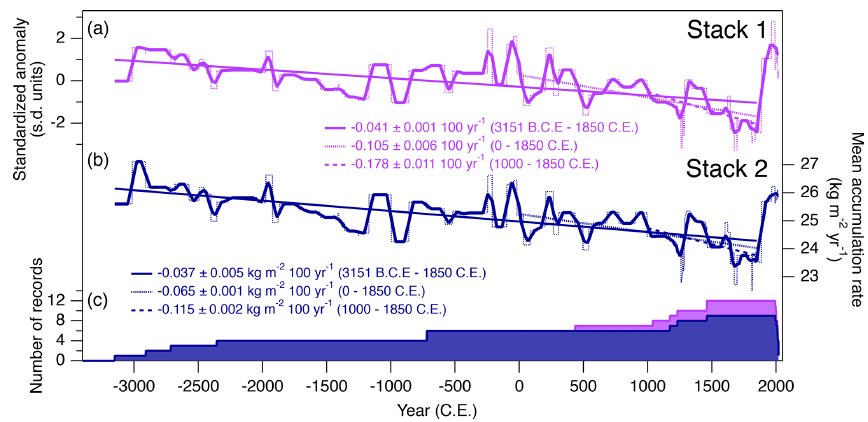
Figure 8. Composites of accumulation rates over the last 5000 years after (a) normalizing using both the mean and standard deviation of each core (Stack 1) and (b) normalizing only using the mean of each core near Dome Fuji (Stack 2). (c) The number of records that contribute to the composite. See Sect. 3.2 for details of stacking methods. Table 4. Accumulation rate for the last few decades from snow pit data. Observation date Surface to Pinatubo (1992) Surface to bomb test (1966) Surface to Agung